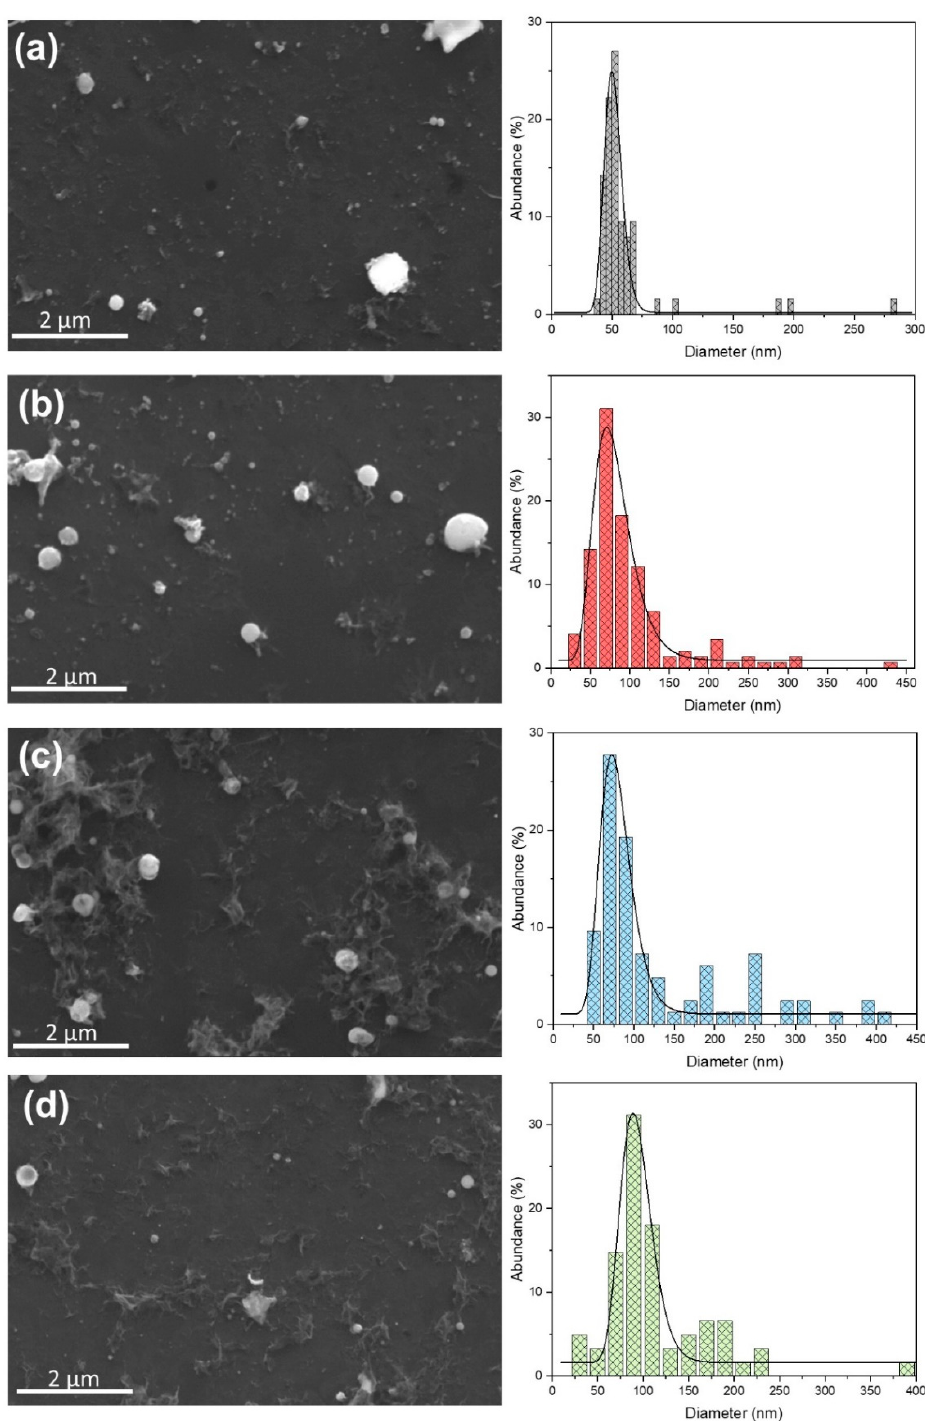
Figure 10. SEM images and size-distributions of ( a ) pure ZnO, ( b ) Ag-doped ZnO, ( c ) Au-doped ZnO, and ( d ) Pt-doped